Question: What does this figure show? Answer in one sentence.
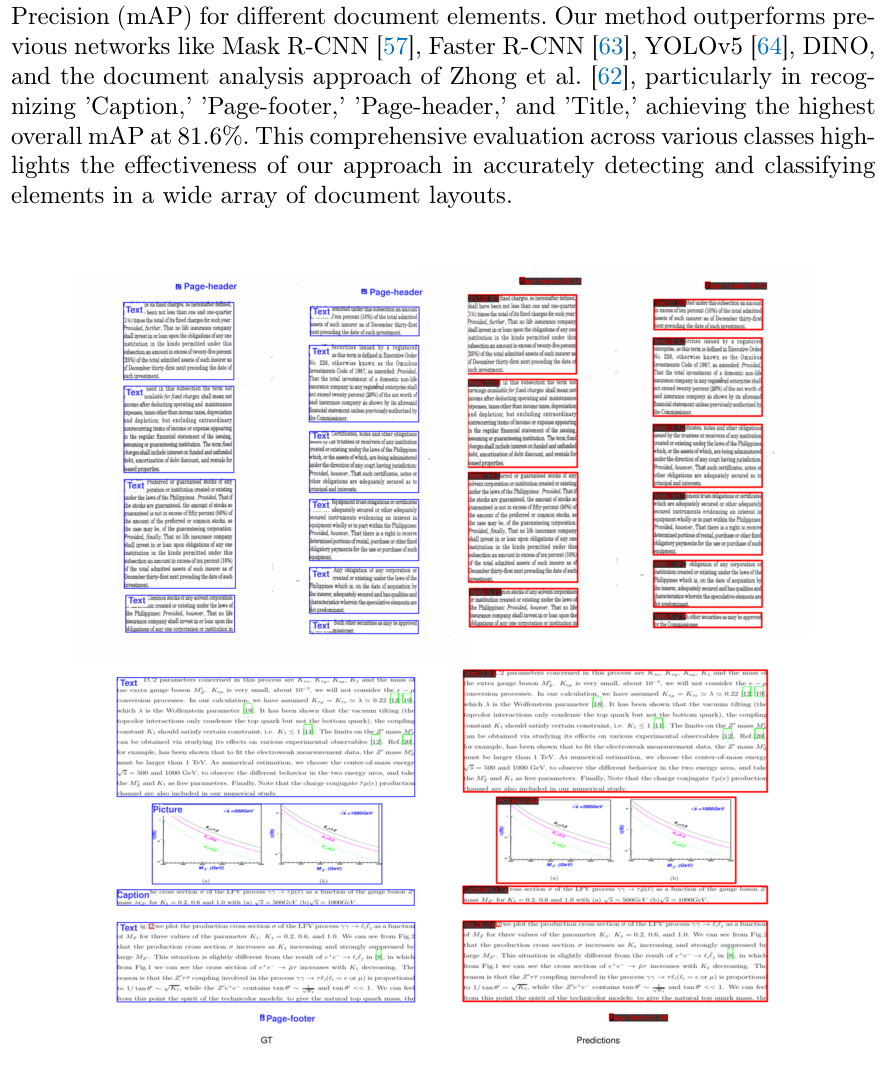
Answer: Visual analysis of our approach on the DocLayNet dataset. Here, blue color represents ground truth, red denotes prediction by our approach. It illus- trates the model’s proficiency in identifying small layout elements, specifically highlighting its accuracy in detecting page titles, headers, and footers.